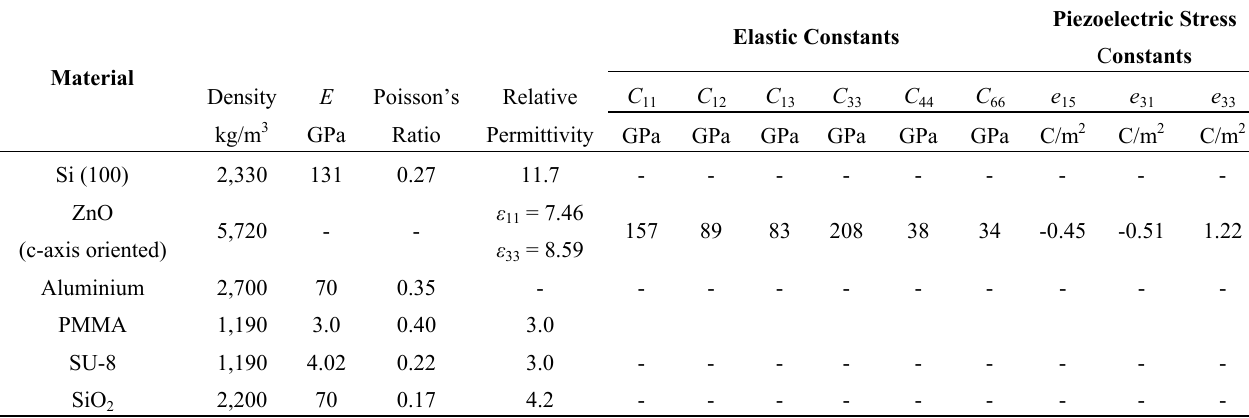
Table 2. Material constants used in the FEM